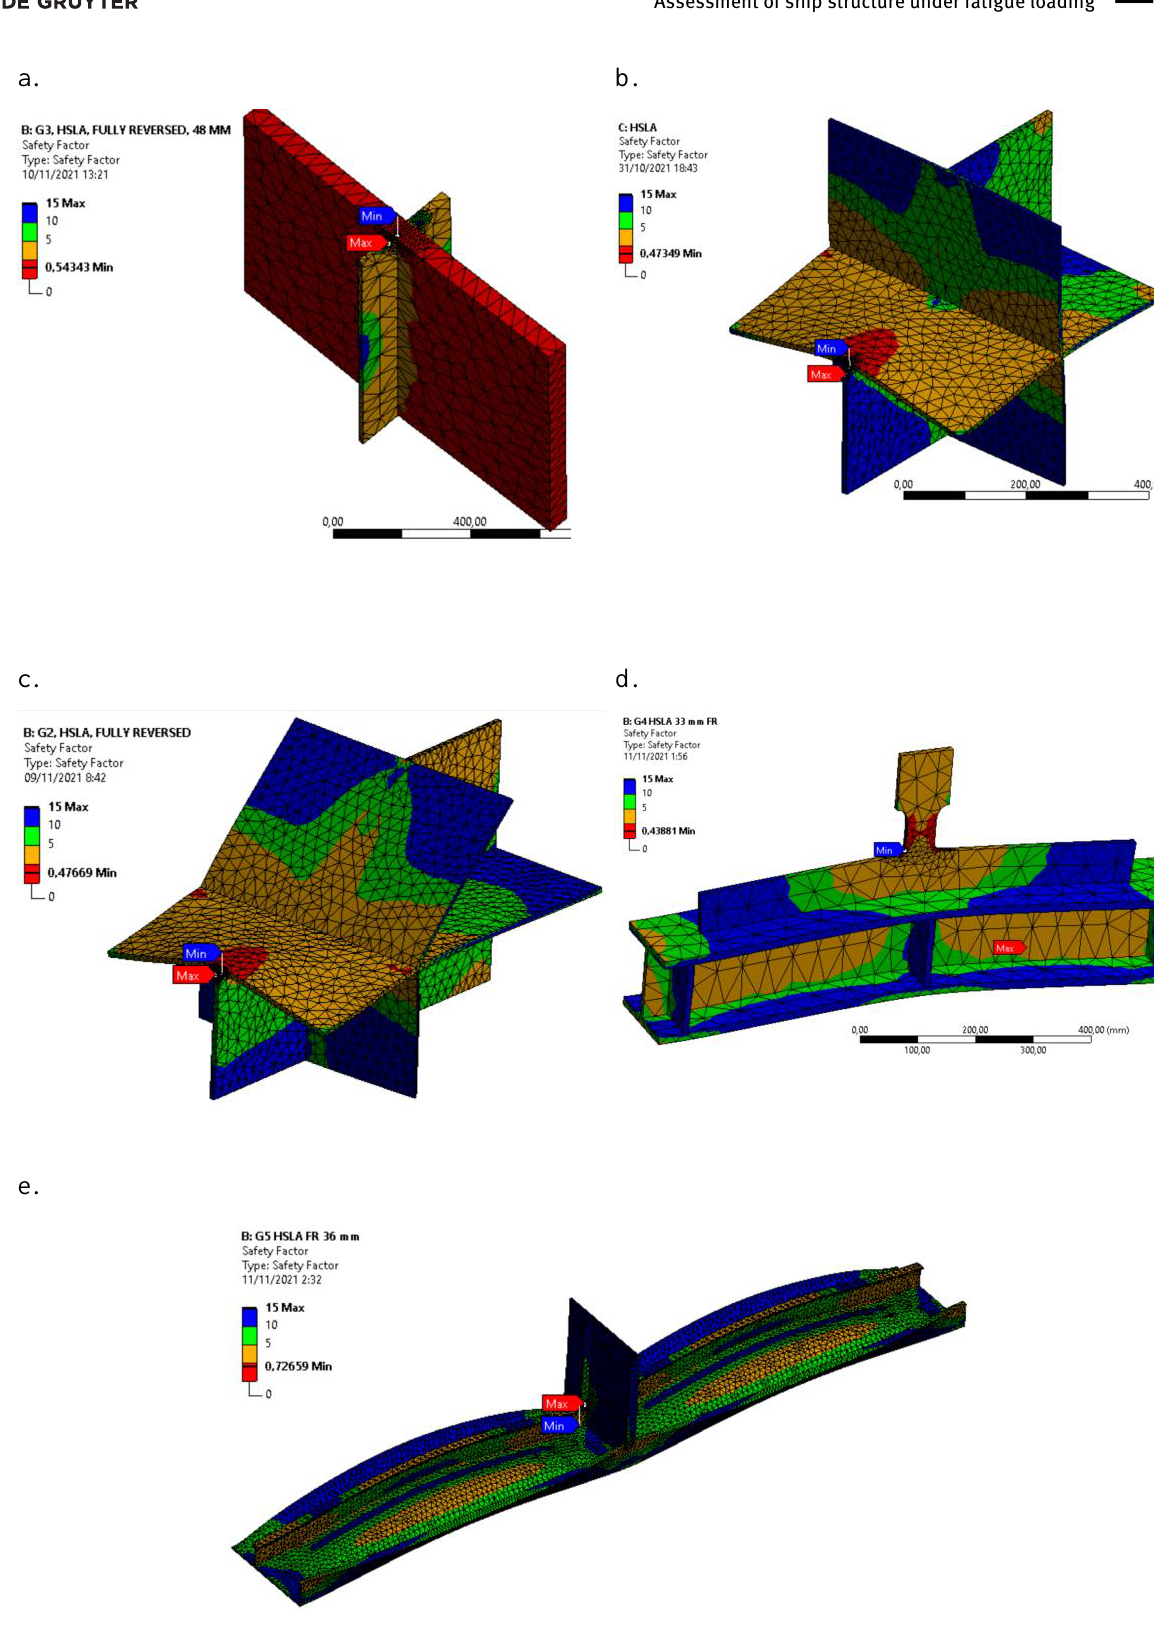
Figure 14. Safety Factor Results: a. Geometry 1: Hatch Coaming Model [16]; b. Geometry 2: Perpendicular Joint Figure 14: Safety factor results: a. Geometry 1: Hatch coaming model [16]; b. Geometry 2: Perpendicular joint [12]; c. Geometry 3: Stool joint [12]; d. Geometry 4: Bottom-stiffened panel [28]; e. Geometry 5: Side-stiffened panel [12]; c. Geometry 3: Stool Joint [12]; d. Geometry 4: Bottom-Stiffened Panel [27]; e. Geometry 5: Side-Stiffened Panel [28]